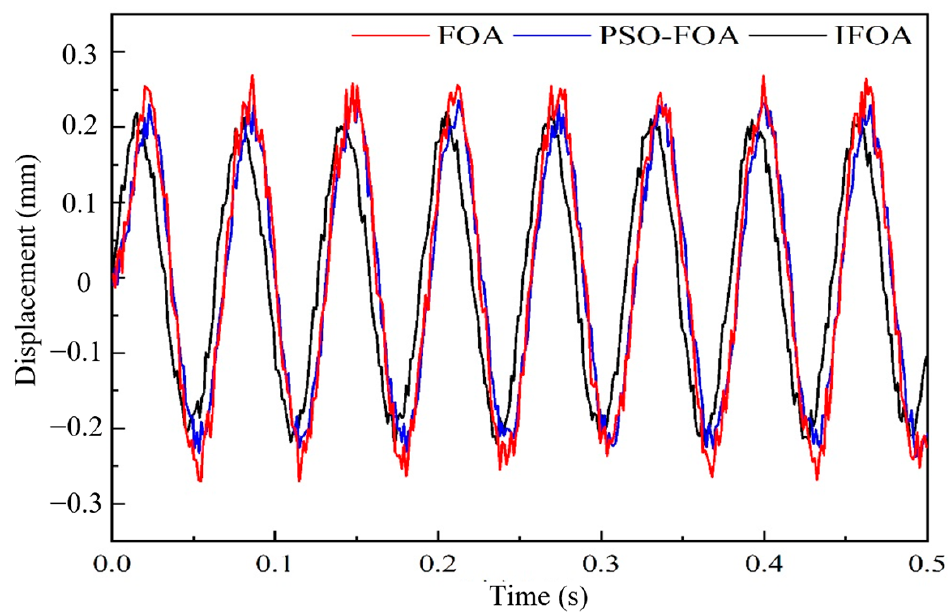
Figure 22. Displacement of frame t at high frequencies.